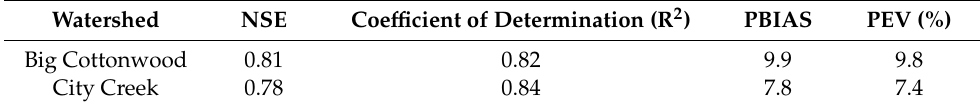
Figure 6. Validation results of the hydrologic models developed for Big Cottonwood and City Creek. Table 5. Validation results for Big Cottonwood and City Creek watersheds .